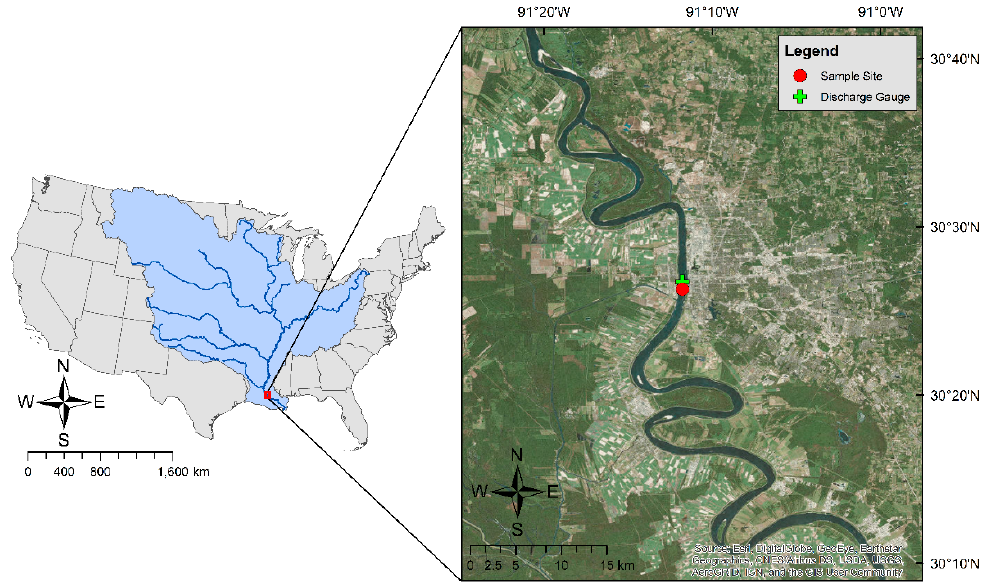
Figure 1. Mississippi River Basin with a vast drainage area of 3.2 million km 2 and the locations of the sampling site and U.S. Geological Survey gauge station (USGS #07374000).